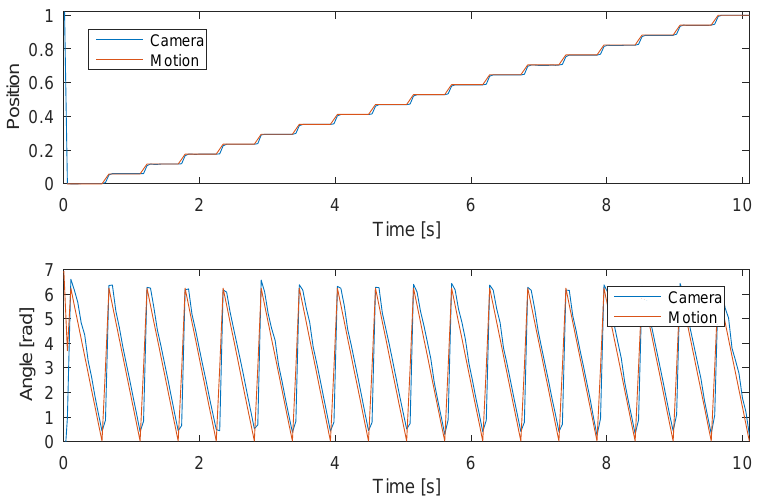
Figure 15. Experiment 3—tracking both linear ( top ) and angular position ( bottom